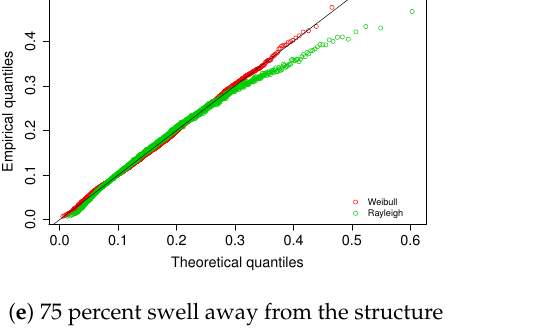
Figure 9. Comparisons of performance of wave height distribution using Weibull and Rayleigh plots for different swell percentages both away ( a , c , e ) and near the structure ( b , d , f